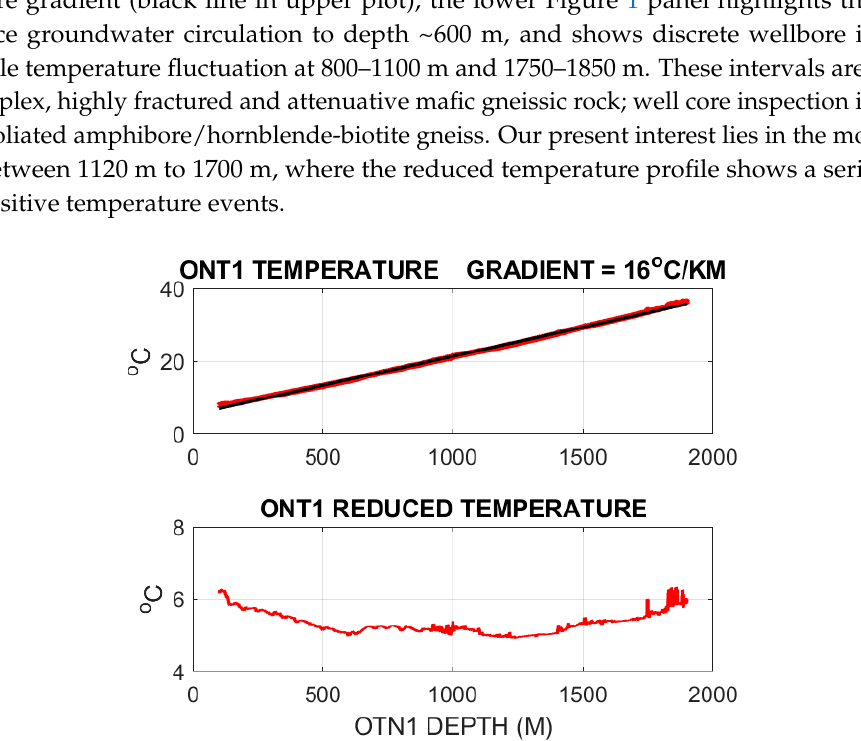
Figure 1. OTN1 temperatures ( Upper ) and reduced temperatures ( Lower ) between 100 and 1900 m; in upper plot, black line denotes constant-gradient fit to temperature data in red. in upper plot, black line denotes constant-gradient fit to temperature data in